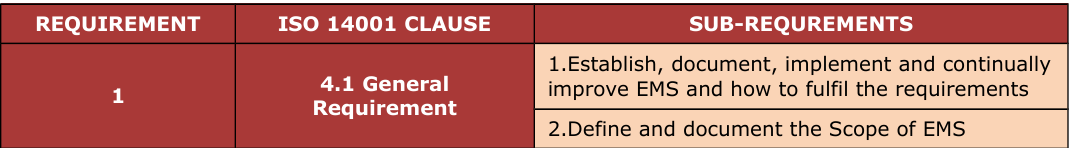
Table 4. Refinement of ISO14001 standard